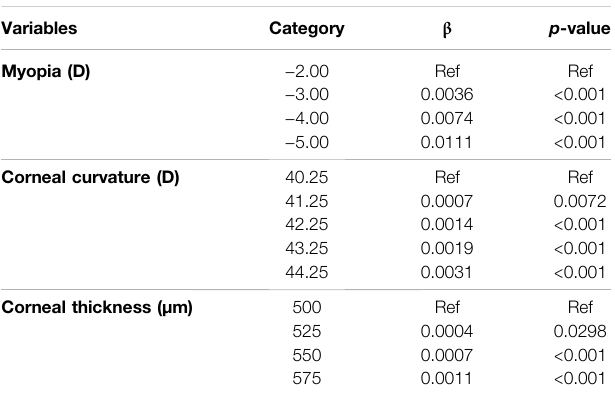
TABLE 7 | Quantile regression results of corneal peripheral stress and independent